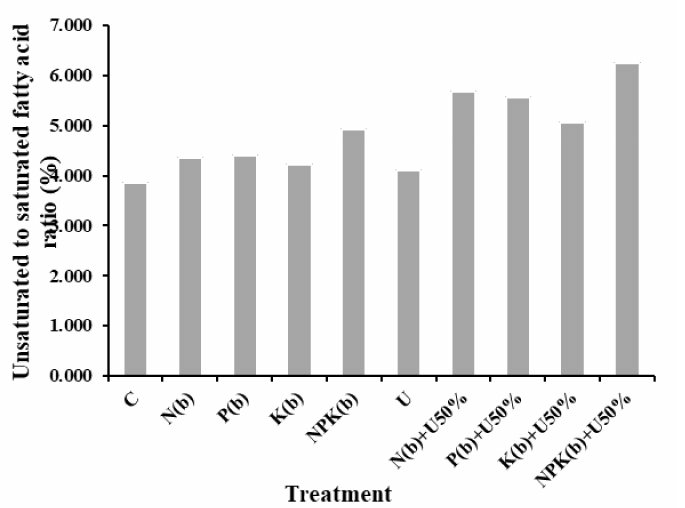
Figure 6. Unsaturated to saturated fatty-acid ratio (chemical urea fertilizer (U), biofertilizer N(b), biofertilizer P(b), biofertilizer K(b), mixed biofertilizer NPK(b), 50% urea + biofertilizer N (N(b)